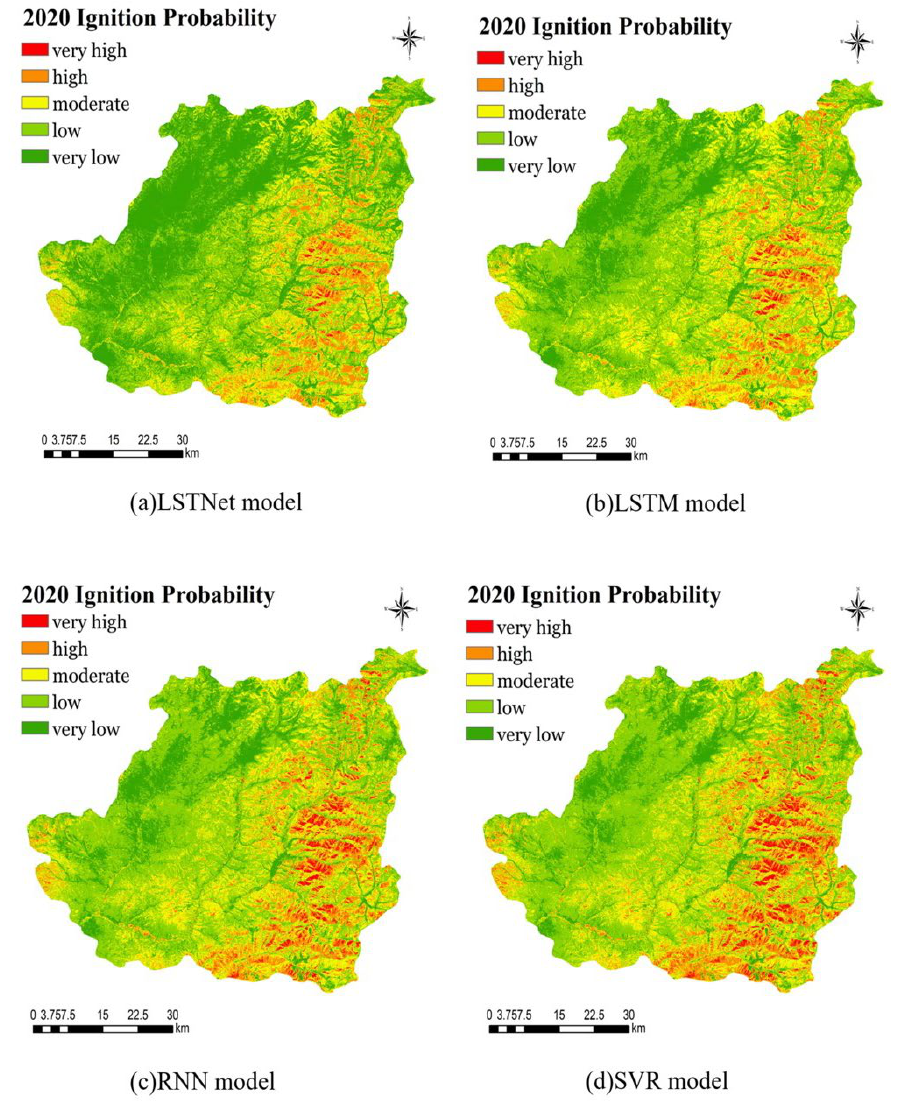
Figure 8. Premonition map of forest fire risk in Chongli